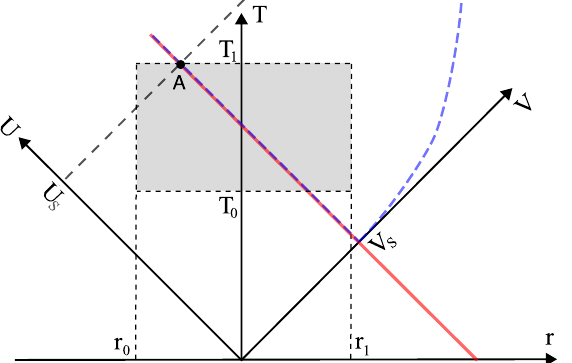
Figure 3. The shaded rectangle is the region V defining the transition amplitude. The blue dash curve for V > V s is the outer trapping horizon, and the inner trapping horizon coincides with the collapsing thin shell at the speed of light (the red line at V = V s ). The contribution of this domain V to the matrix element is dominated by a neighborhood of the point ( U s , V s )